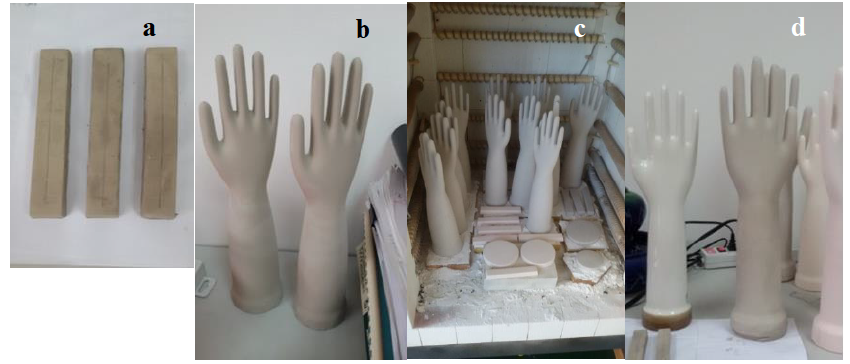
Figure 2: Slip cast porcelain and bone china hand